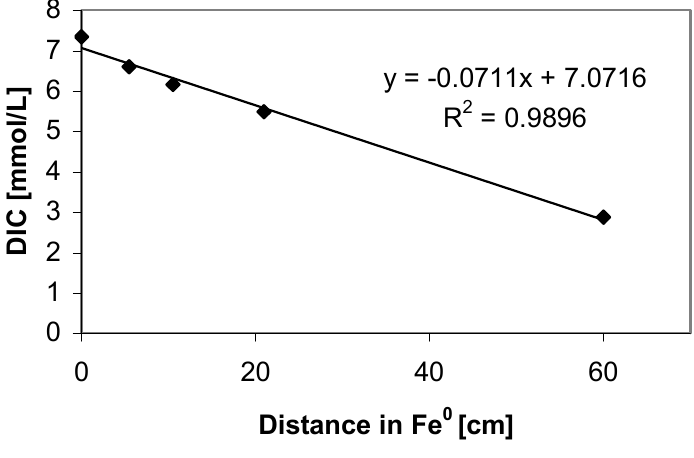
Fig. 8 Concentration of DIC (mmol · l − 1